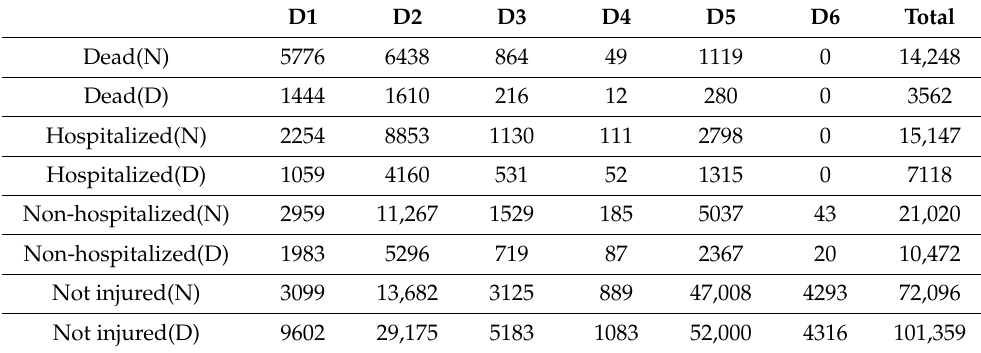
Table 14. Number of casualties in the 1721 earthquake in District 5 of Tabriz.